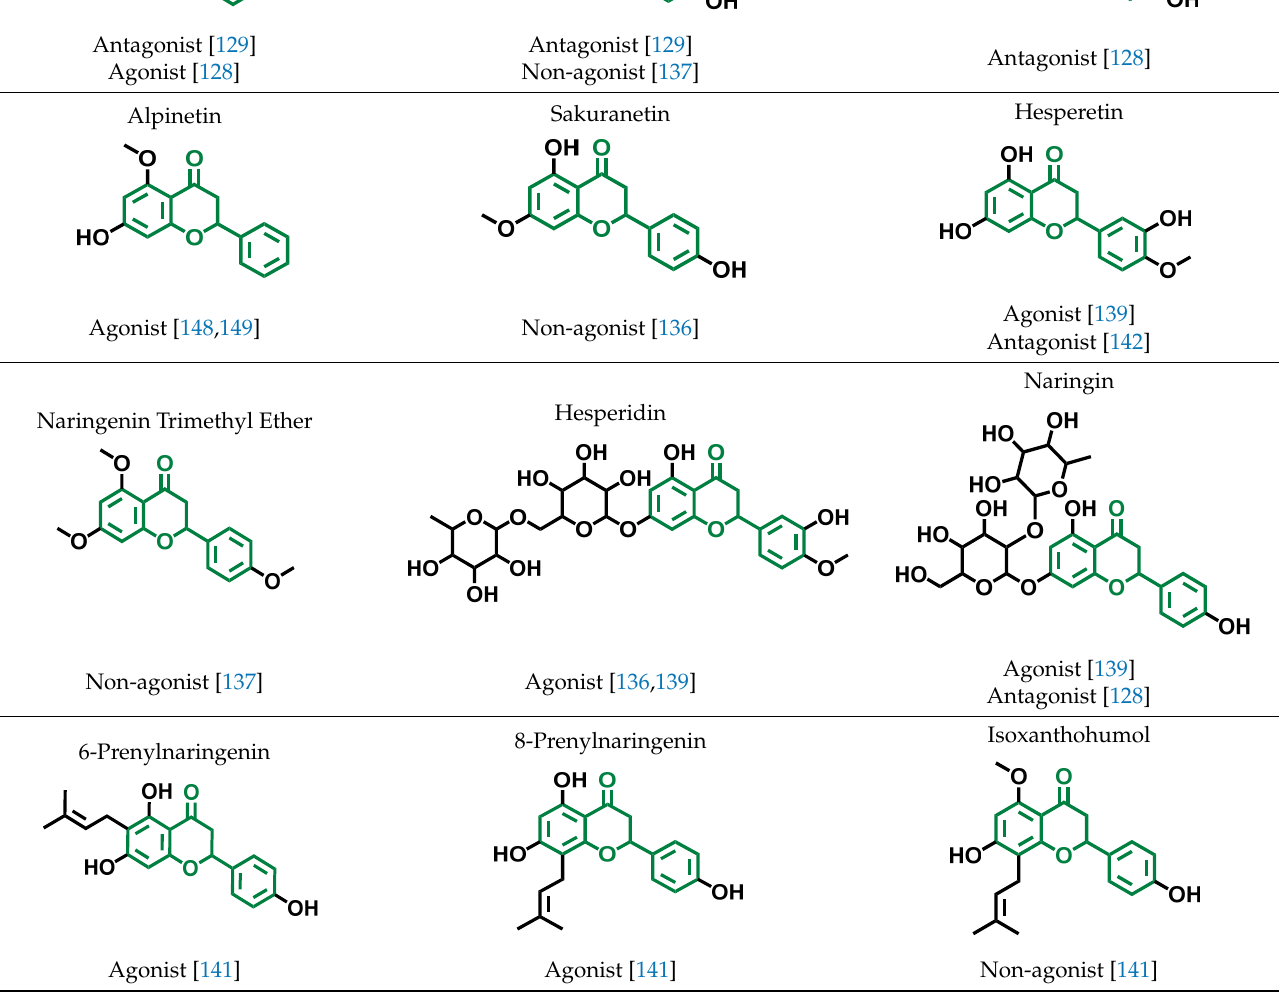
Table 5. Structures and AhR activity reported for the isoflavone class of compounds.